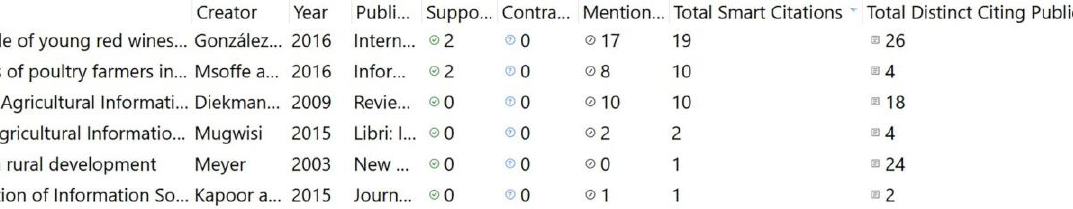
Figure 1 In the desktop version of Zotero, the Scite plug-in displays columns with counts of supporting, contrasting, and